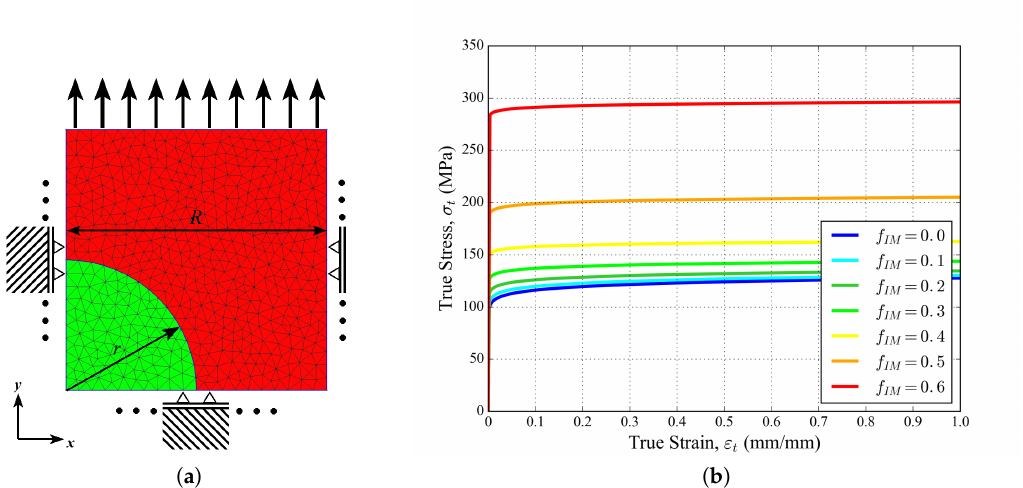
Figure 4. ( a ) 2D axisymmetric model of the aluminum matrix material (red) with a given intermetallic (green) volume fraction f IM . The right exterior line remains straight and vertical during loading, but is free to move in the radial direction. ( b ) Resulting hardening behavior for increasing intermetallic volume fraction.